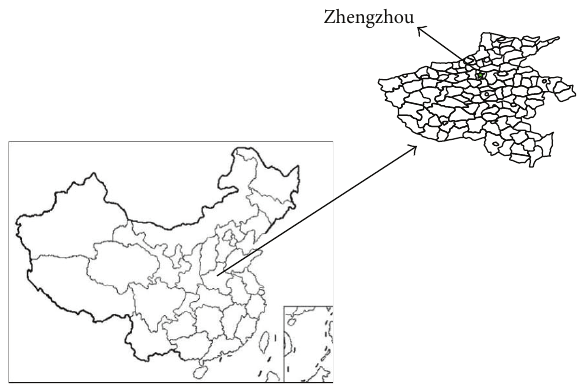
Figure 1: The location of Zhengzhou (Henan province) in